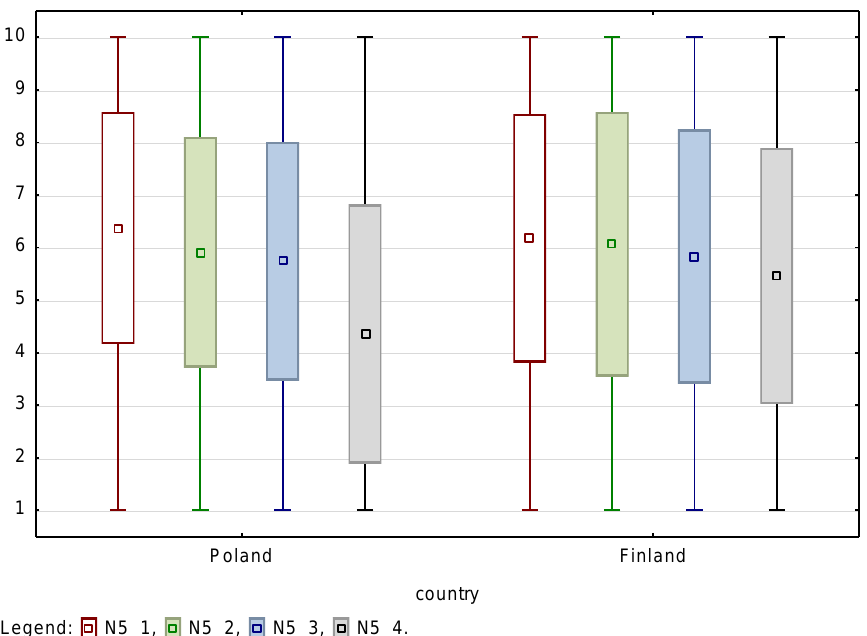
Figure 3. Box-and-whiskers plots for acceptance of four types of PwD.